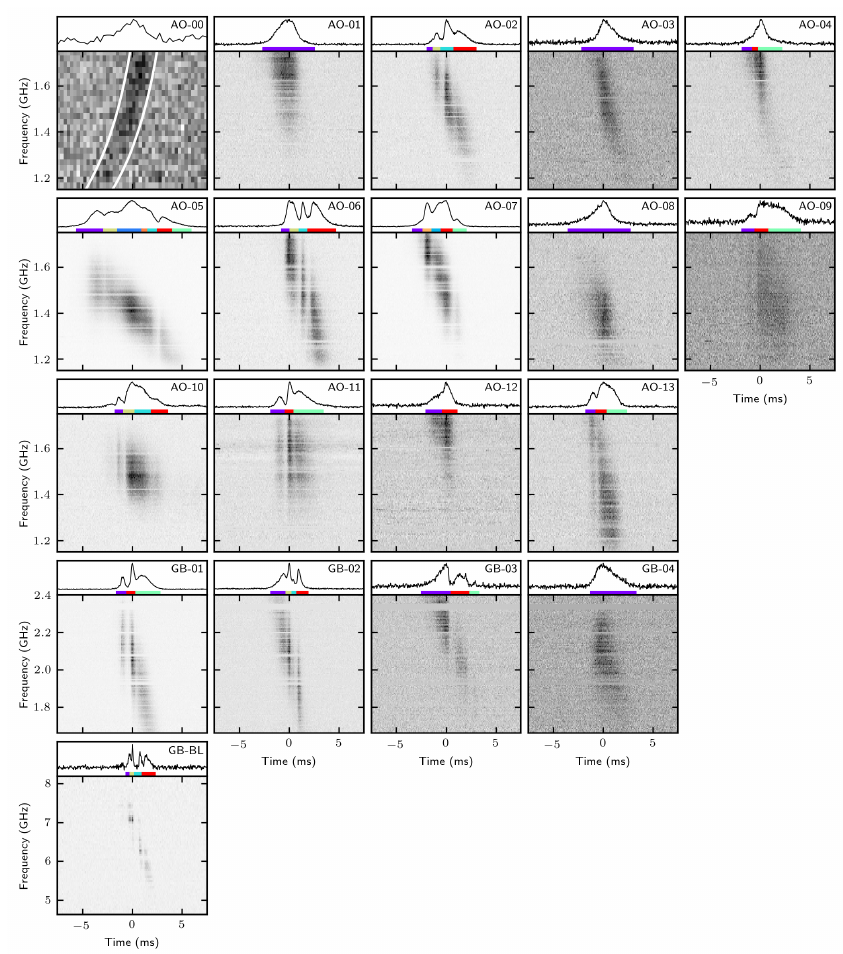
Figure 2. Figure 1 from [46] “FRB 121102 Bursts Show Complex Time-Frequency Structure”, repro- duced with permission from Jason Hessels; published by ApJL (IOP Publishing), 2019. It shows the complex morphology of different bursts from FRB20121102A as observed by GBT and Arecibo. The top of each plot represents the profile, and the bottom represents the dynamic spectrum dedispersed at DM = 560.5pccm − 3 . The presence of a sub-burst structure is evident in these bursts, and it is highlighted by the colored bars below each profile. The sub-bursts show a downward drifting trend with the frequency which has been dubbed “sad trombone” (see Section